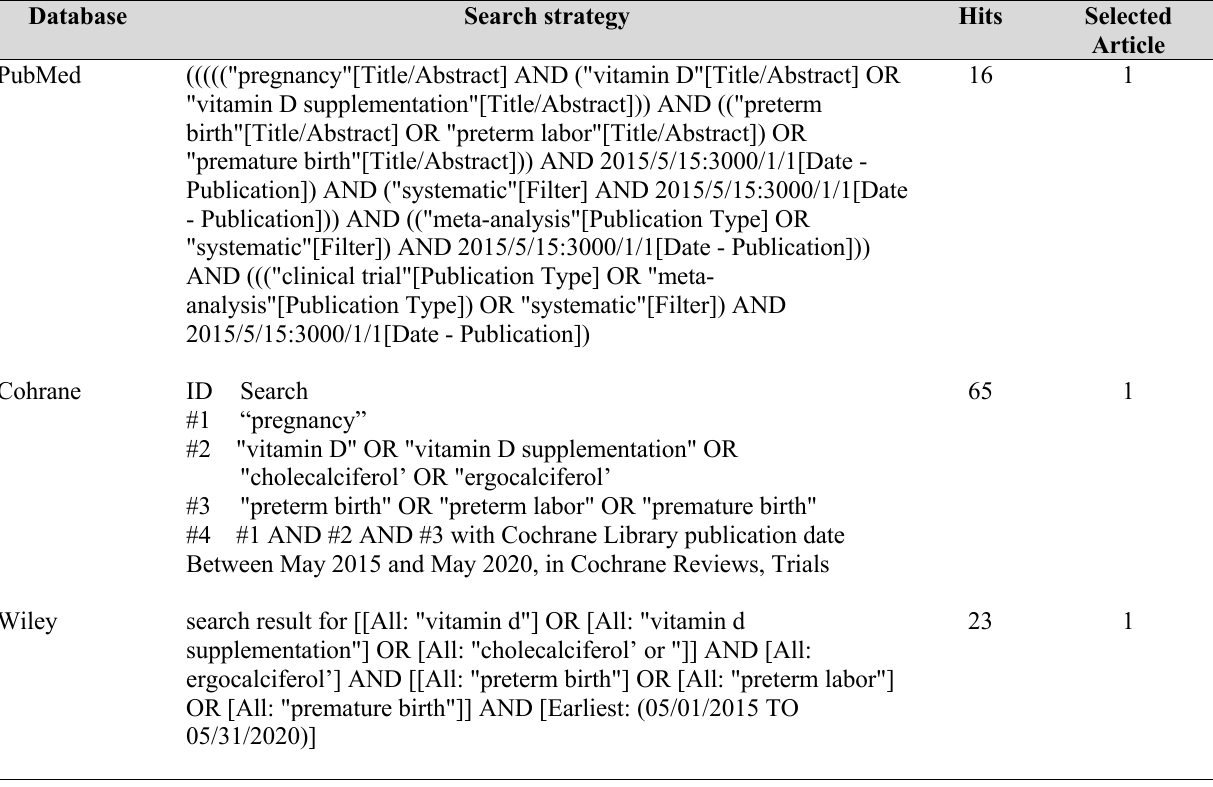
Table 1 . Resources and search strategy Database Search strategy Hits